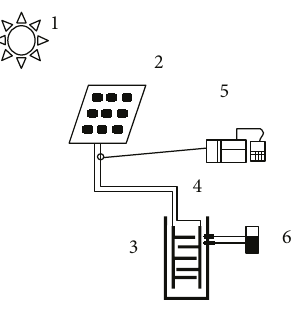
Figure 1: Scheme of the experimental system: 1, solar energy; 2, photovoltaic module; 3, electrochemical reactor; 4, direct connection of the power supply; 5, parameter control: current, voltage, and solar radiation; 6, pH, conductivity, and temperature control. Table 1: Characterization of the remazol yellow